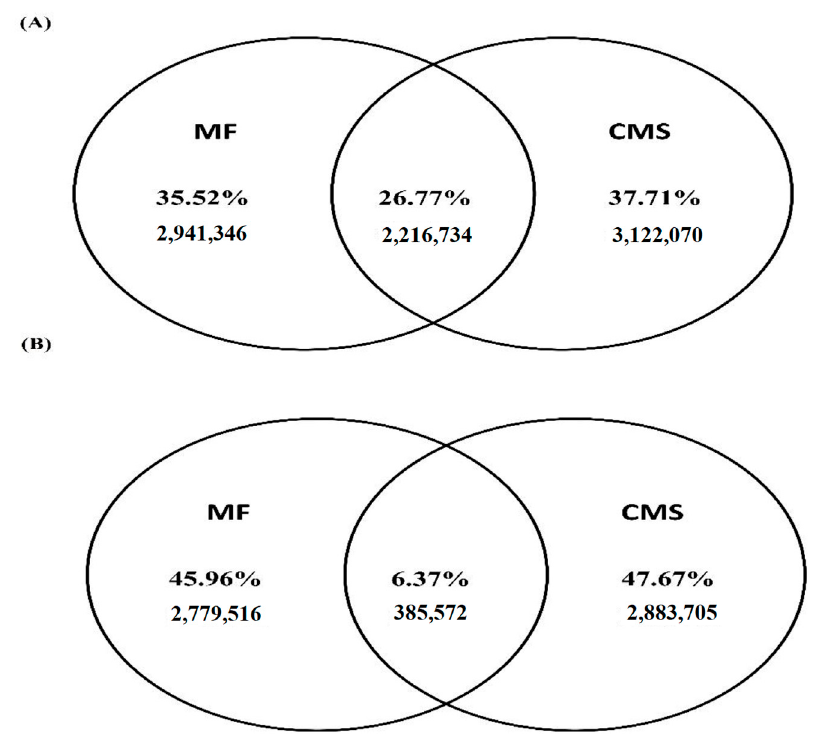
Figure 2. Distribution of common and unique small RNAs between MF and CMS libraries. ( A ) Total